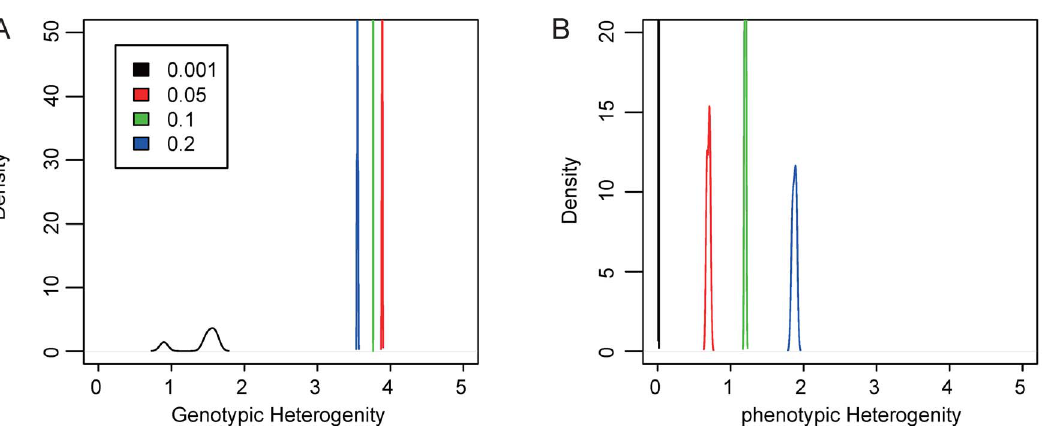
Fig. 1. Heterogeneity levels when a population is subjected to stabilizing selection. This figure shows the density of converged heterogeneity levels from 50 replications of simulation for a population with 100 individuals. The colors represent the mutation rates. A) genotypic heterogeneity and B) phenotypic